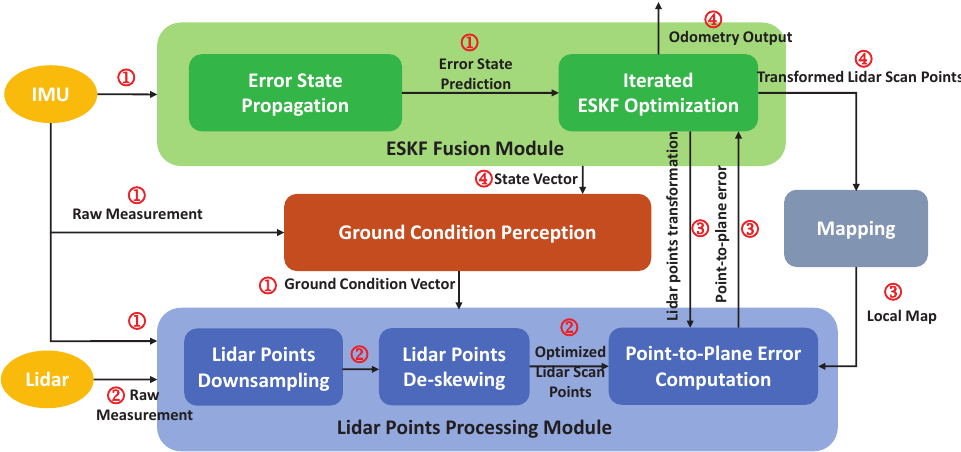
Figure 1. The overall architecture of the lidar-inertial odometry system proposed in this